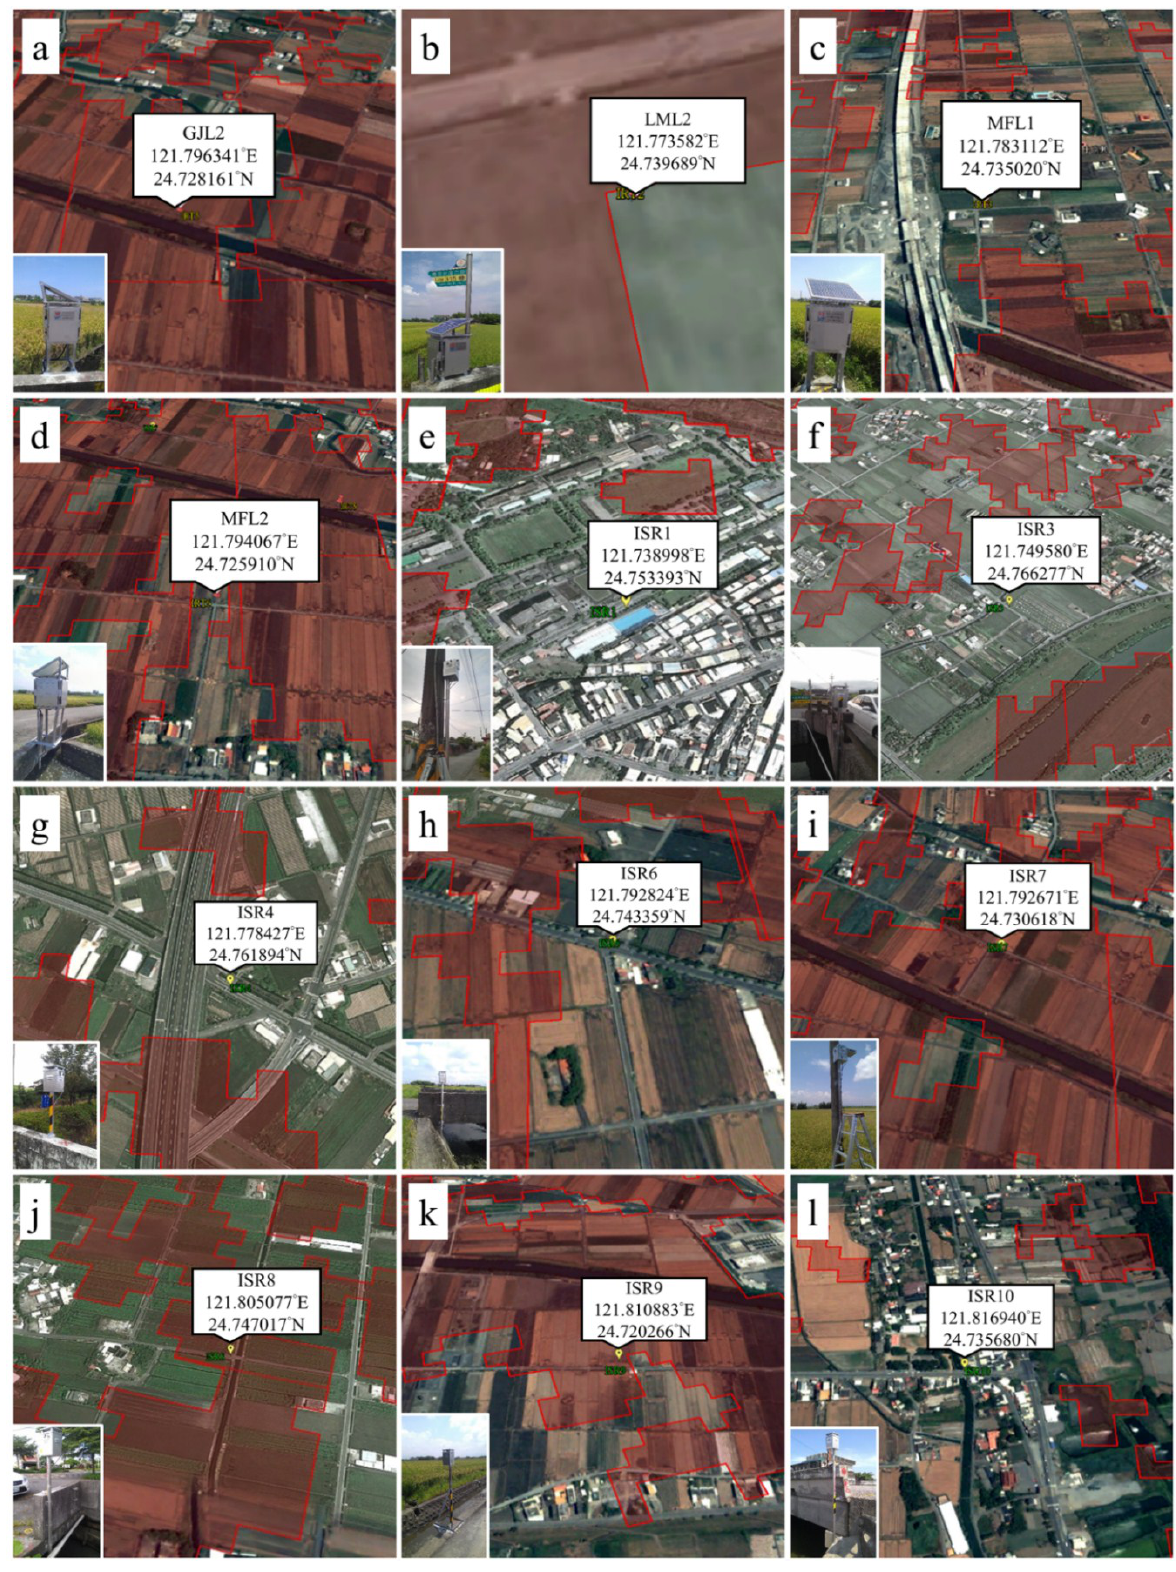
Figure 9. The close-up photo of the water level gauge and the inundated areas (red shaded polygons) interpreted from the SAR imagery of twelve stations: ( a ) GJL12, ( b ) LML2, ( c ) MFL1, ( d )MFL2, ( e ) ISR1, ( f ) ISR3, ( g ) ISR4, ( h ) ISR6, ( i ) ISR7, ( j ) ISR8, ( k ) ISR9, ( l ) ISR10, the name and location of each station is defined and illustrated in Figure 3 that were fully in accordance with the interpretation